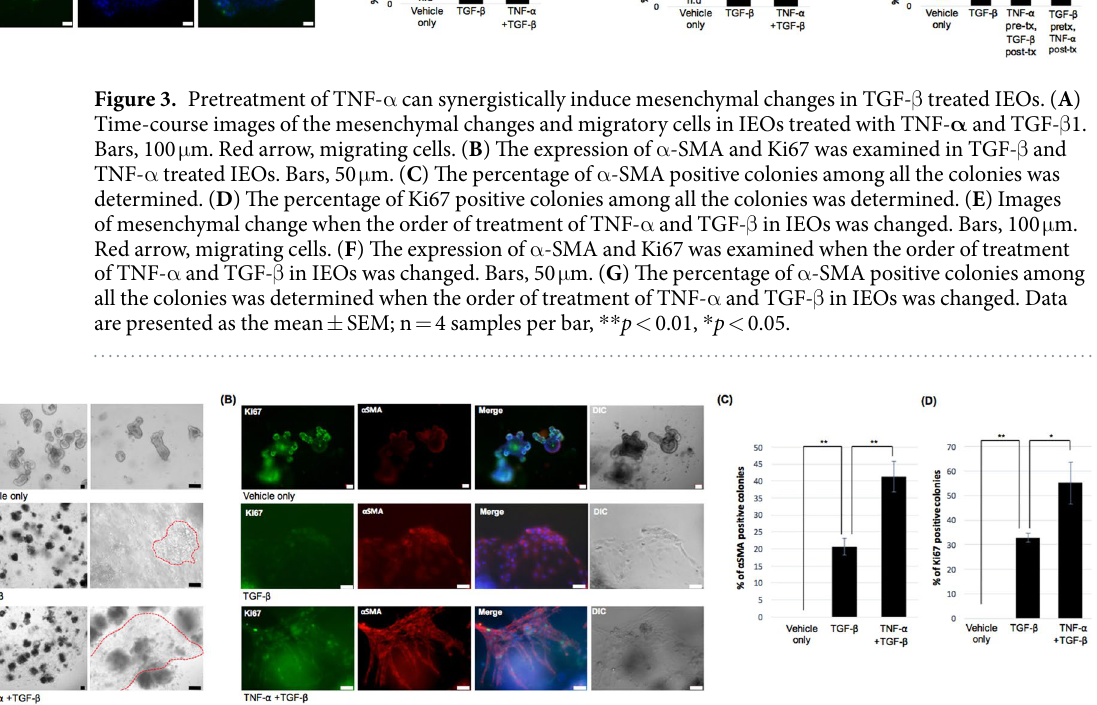
performed morphological analyses at 2 days after the TNF- α treatment. We observed two morphological char- acteristics of the TNF- α treated IEOs: irregularly budded shaped IEOs and smoothly spherical shaped IEOs (Fig. 5A). The number of budded IEOs in the high dose TNF- α treated IEOs was less than that of the low dose TNF- α treated IEOs. Conversely, the number of spherical changed IEOs was greater in the high dose TNF- α treated IEOs than in the low dose TNF- α treated IEOs (Fig. 5B). The increase in the number of spherical and